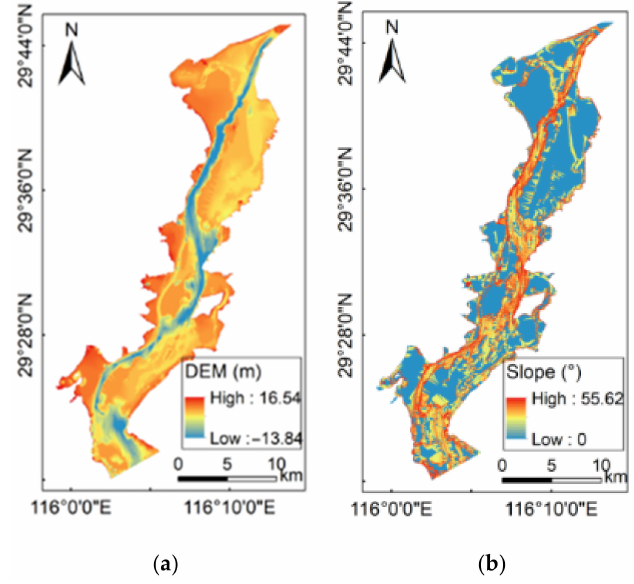
Figure 3. ( a ) Bathymetry and ( b )